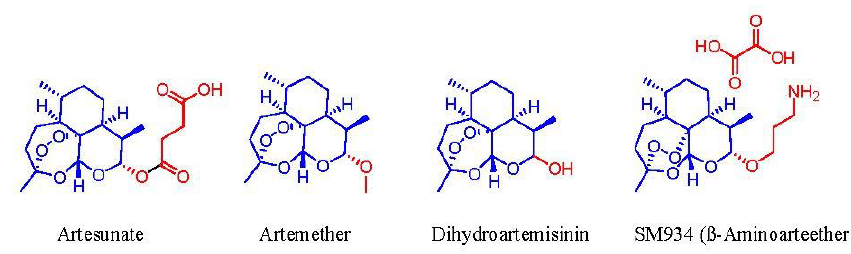
Figure 11. Artemisinin’s derivatives.